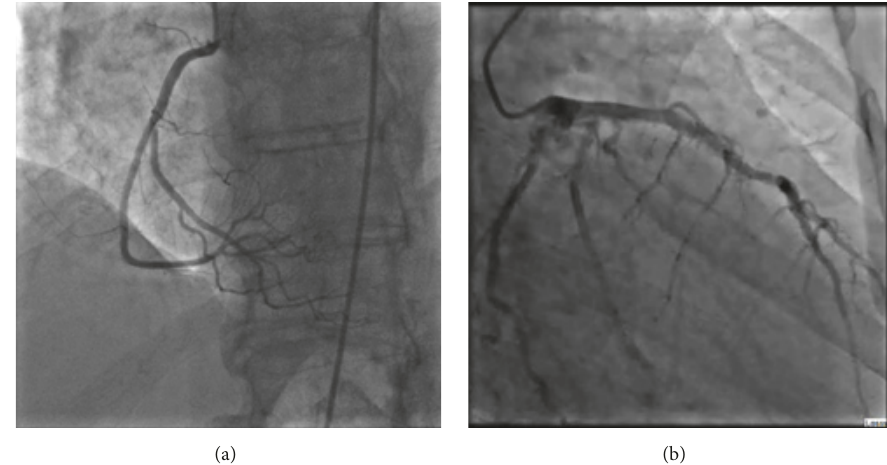
Figure 2: (a) and (b): cardiac catheterization on day of admission revealing no obstructive coronary artery disease in RCA and LAD,